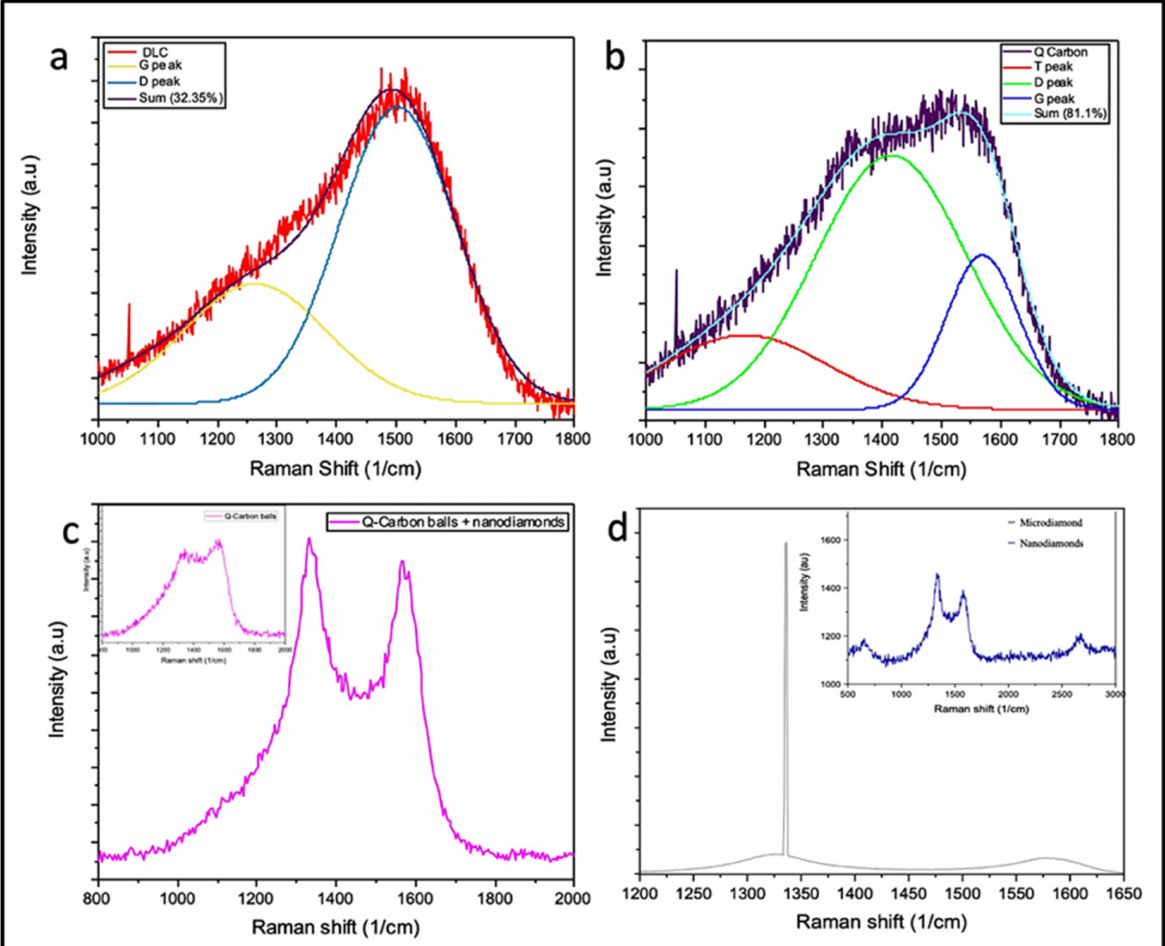
Figure 4b. Gaussian distribution was used for curve fitting and deconvolution of the peaks.